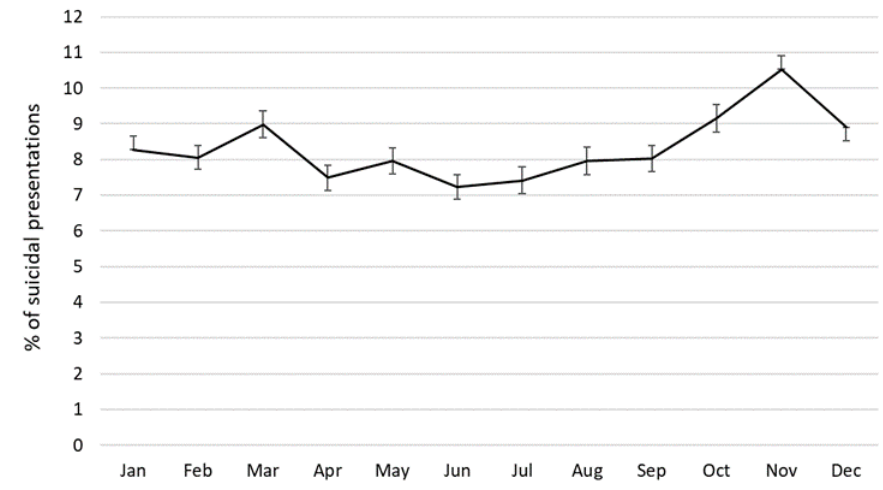
Figure 3. Seasonal distribution of suicidal presentations, 2009–2018.